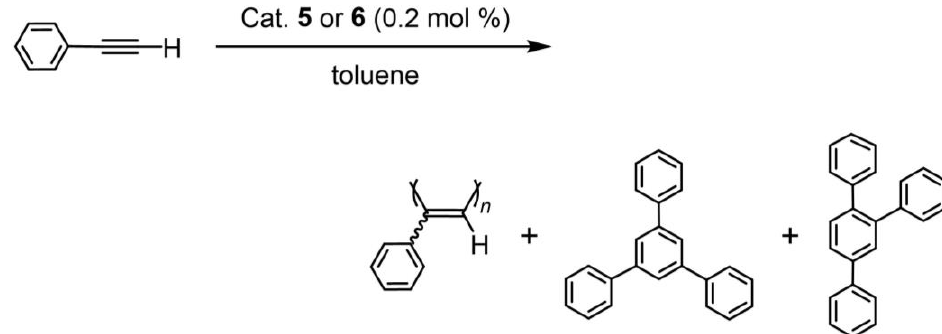
Table 3. Polymerization of phenylacetylene catalyzed by 5 or 6 1 . Temp. Entry Cat. [°C]